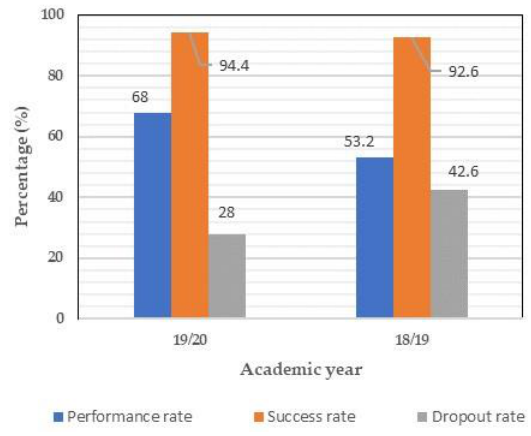
Figure 8. Academic Figure 8. Academic results.